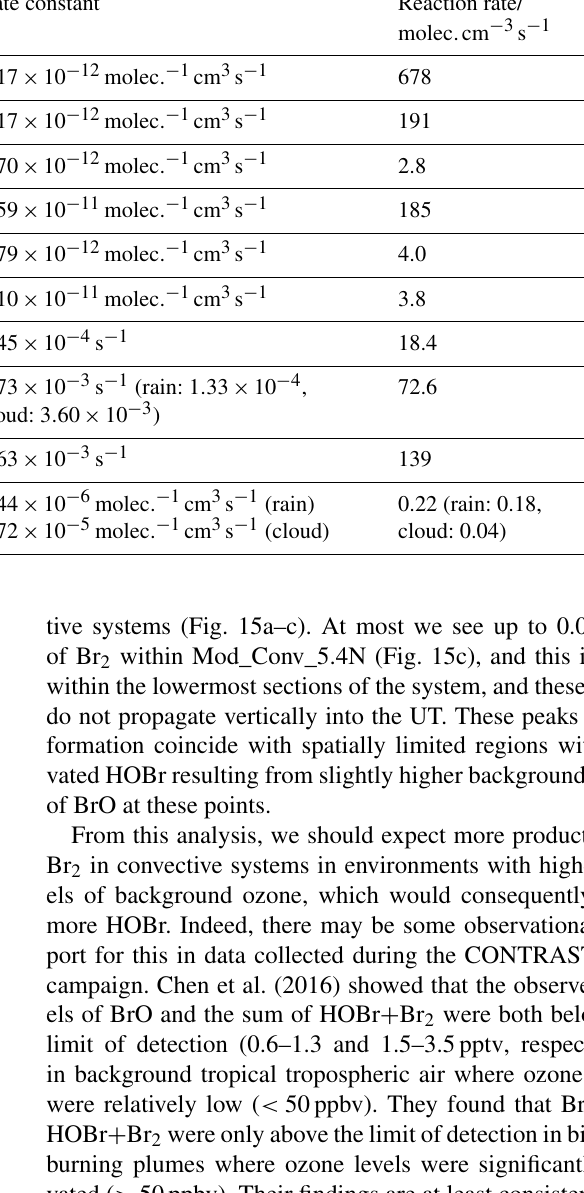
Table 4. Rate constants and reaction rates at a point in the marine boundary layer (200m, 988.7mb, and 298.7K) within an air mass being advected into the convective updraught of Mod_Conv_5.4N (5.8 ◦ N 115.5 ◦ E). This was done based on chemical species’ mixing ratios at this location for all of the Reactions (R1)–(R9) discussed in Sect. 4.3.4. This was in a region with no cloud or rain. For Reactions (R8) and (R10), the reactions taking place in the aqueous phase, we select some representative rain and cloud water mass mixing ratios (0.5 and 0.1gkg − 1 , respectively) to demonstrate the reaction rates in the presence of liquid water condensate. In the case of Reaction (R10) the hypothetical reaction rate is calculated using the aqueous concentration of HOBr at Henry’s law equilibrium, and due to the extremely high solubility of HBr it is assumed that all of its gas-phase mixing ratio is dissolved in solution. For both Reactions (R8) and (R10) the reaction rates in cloud and rain droplets are shown separately, but in the case of Reaction (R10) they cannot be combined additively. Reaction Mixing ratio of Mixing ratio of Rate constant Reaction rate/ 1st reactant 2nd reactant molec . cm − 3 s − 1 (R1): Br + O 3 0.08ppqv 13.1ppbv 1 . 17 × 10 − 12 molec . − 1 cm 3 s − 1